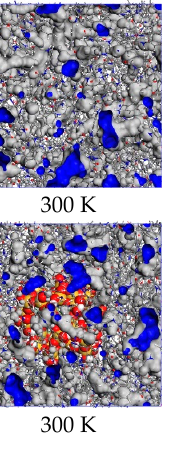
Figure 6. Free volume distribution of the model at different temperatures.